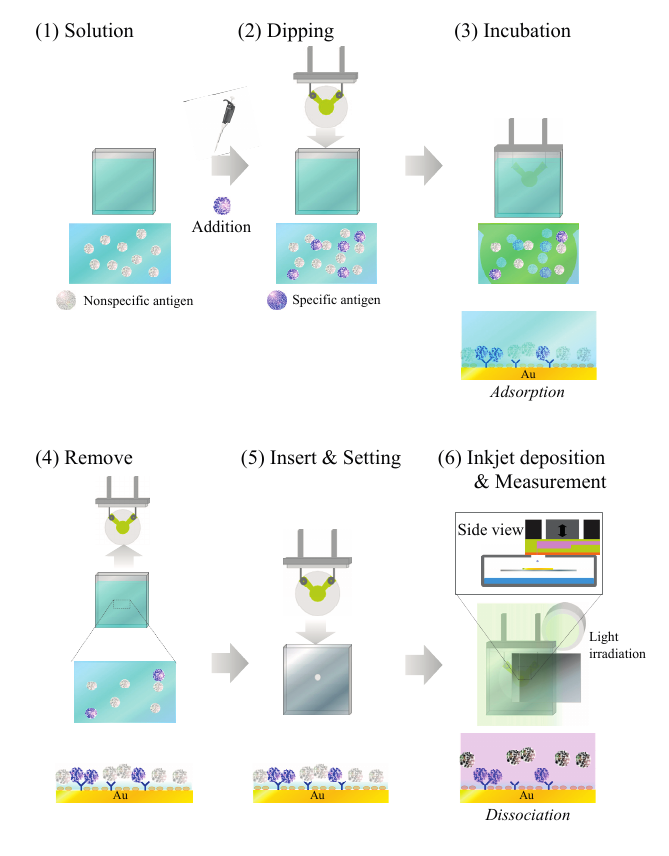
Figure 5. Immunoassay process with the developed QCM sensor